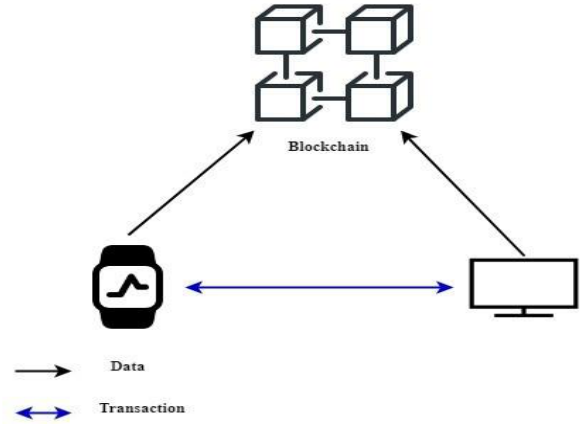
Figure 12. IoT – IoT devices interaction.